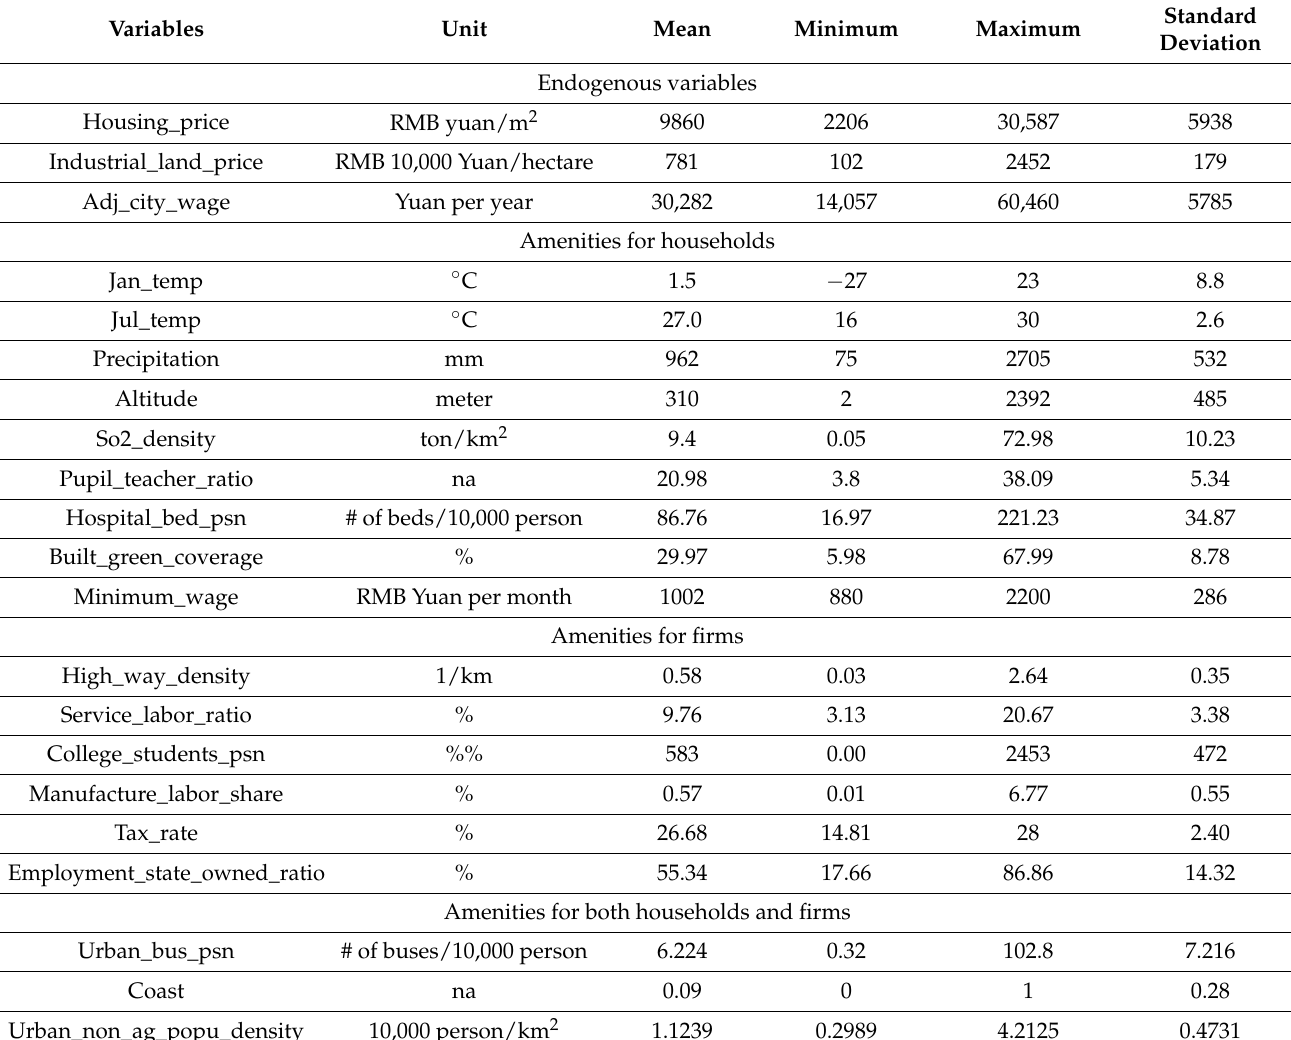
Table 1. Descriptive statistics of all variables (n =